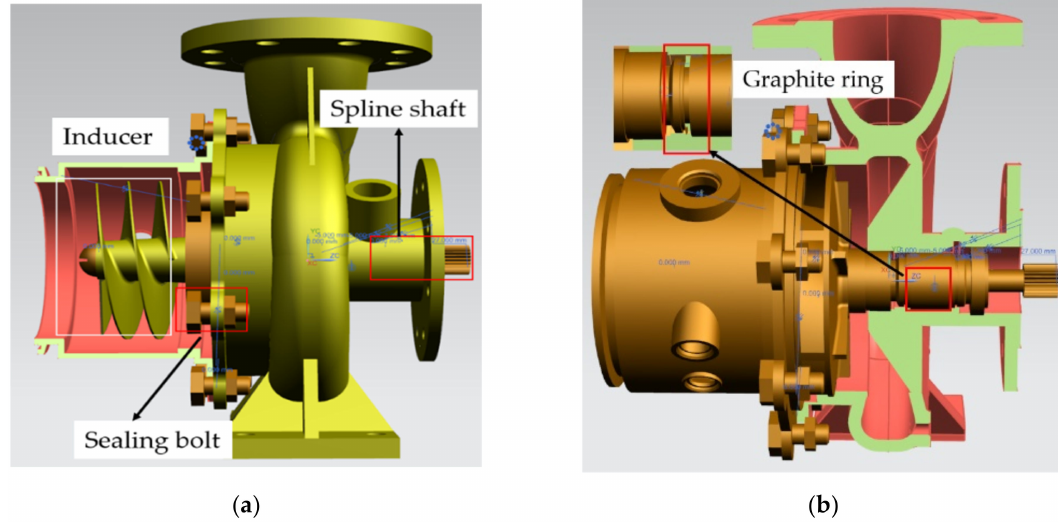
Figure 2. Sectional view of the fuel booster pump: ( a ) left profile; ( b ) right profile.